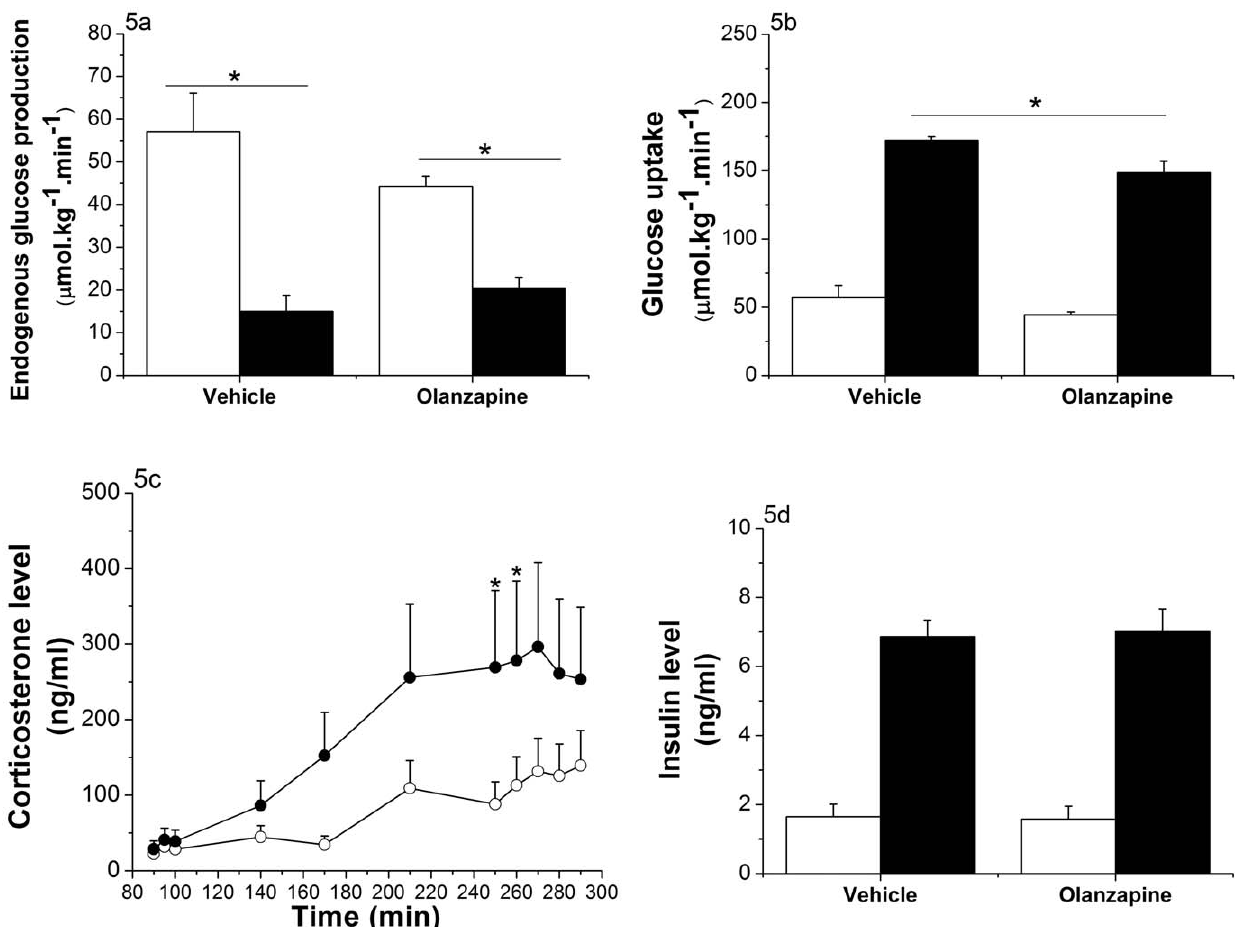
Figure 5. Effects of intragastric infusion of Olanzapine (t=130 to t=290; 3 mg/kg/h) on glucose disappearance (Experiment 3). (Vehicle group n=8, Olanzapine group n=7) 5a: Endogenous glucose production at basal (mean of 3 time points: t=90 to t=100; white bars) and during the hyperinsulinemic state (mean of 5 time points: t=250 to t=290; black bars). EGP is significantly decreased in both groups (p , 0.001), but the decrease is smaller in the group treated with Olanzapine (ANOVA repeated measures; Time, p , 0.001; Time * Group, p=0.018; Group, p=0.604). 5b: Glucose disappearance at basal (mean of 3 time points: t=90 to t=100; white bars) and during the hyperinsulinemic state (mean of 5 time points: t=250 to t=290; black bars). Glucose disappearance is significantly increased in both groups (ANOVA repeated measures; Time, p , 0.001; Time * Group, p=0.475; Group, p=0.005). This increase is significantly smaller for the group treated with Olanzapine (p=0.014, One-Way ANOVA). 5c: Corticosterone levels are significantly increased by the Olanzapine treatment (ANOVA repeated measures; Time, p , 0.001; Time * Group, p , 0.005; Group, p=0.035). Vehicle-treated animals = white dots; Olanzapine-treated animals = black dots. 5d: Plasma insulin levels are elevated 4.4-fold in both groups during the hyperinsulinemic state (mean of 3 time points; black bars) compared to the basal level (mean of 2 time points; white bars) (ANOVA repeated measures; Time, p , 0.001; Time * Group, p=0.787; Group, p=0.938). *p , 0.05.